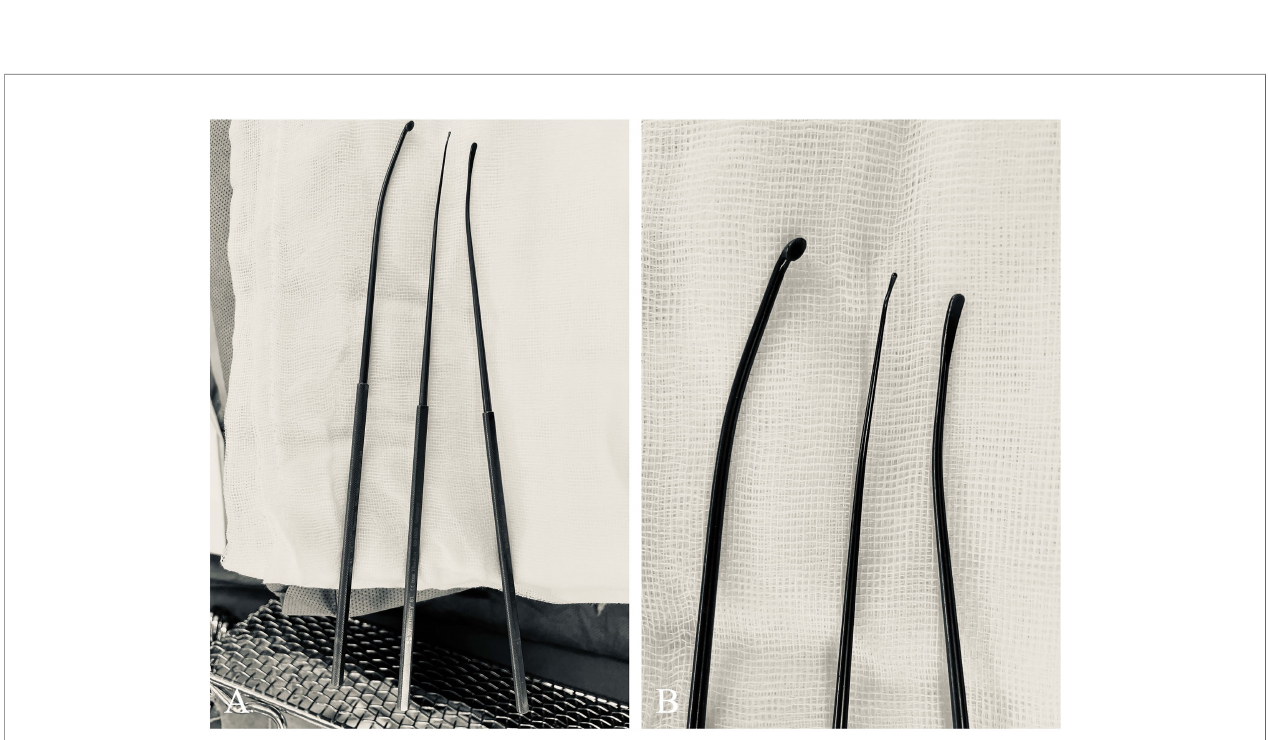
FIGURE 3 | Curated angled instruments used for managing tumors located at the lateral end of IAC. (A) These instruments, modi fi ed from market-sold models (Symmetry Surgical GmbH, Tuttlingen, Germany), were (from left to right) microcurette, angled nerve hook, and micro-Pen fi eld dissector. (B) A close-up view of the tips of these angled instruments.